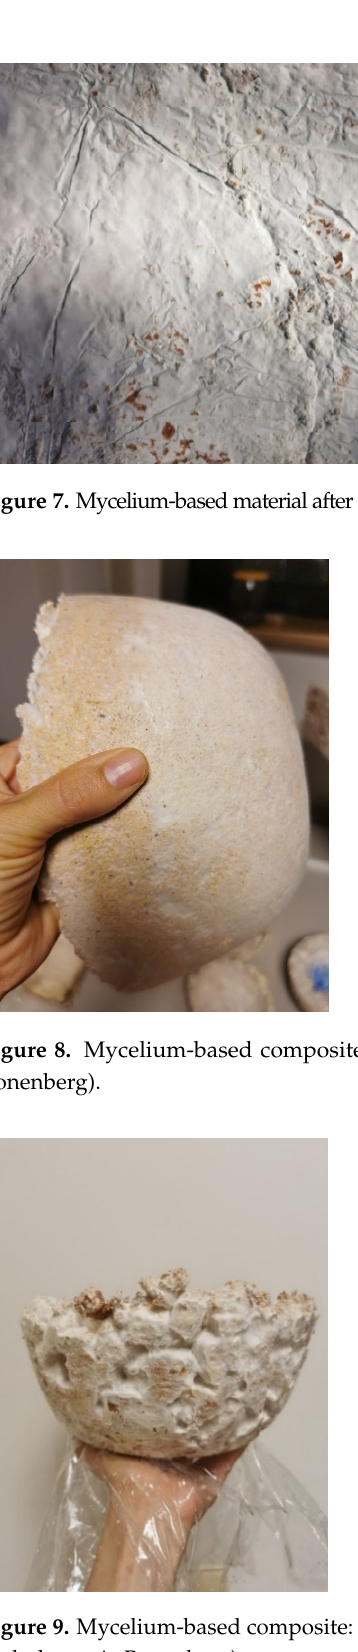
Figure 10. Mycelium-based composite: smooth and rough textures, combined in one object (design and photo: A. Bonenberg). Experimentation with textures and shapes of forms has led to preliminary product development and production. The designs of a table light fixture, a table bowl, and a coffee table have been executed. In each of these projects, mycelium-based elements had to be combined with other materials. The author has chosen natural components such as timber to match the design’s pro-ecological spirit and give overall natural “touch”. The small table lamp is a good example of this approach: a mycelium-grown, cylindrical lampshade has been fixed on a simple cubical timber base (Figures 11 and 12).